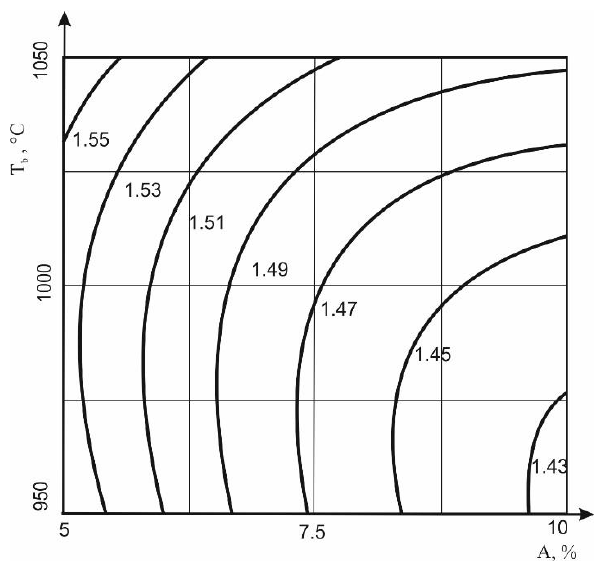
Figure 3. Dependence of the shard density on the amount of additive in the clay and the firing temperature of raw material. Equation of the dependency graph: ρ = 1.47 − 0.05x + 0.02y + 0.02x 2 + 0.01xy + 0.02y 2 .